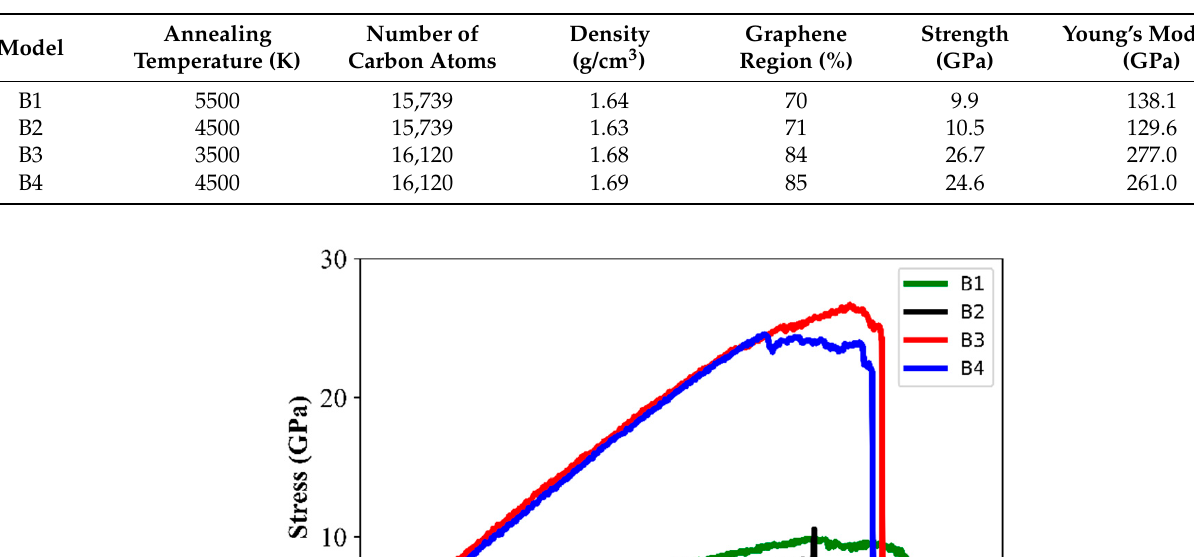
Table 1. The resulting physical and mechanical properties of the used carbon fiber models.